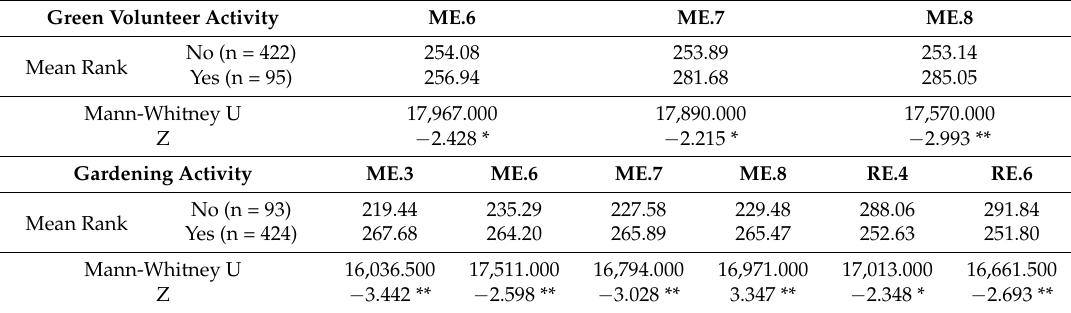
Table 3. Mann-Whitney U test result of the urban green space (UGS) experience (n = 517). Green Volunteer Activity ME.6 ME.7 ME.8 254.08 Mean Rank